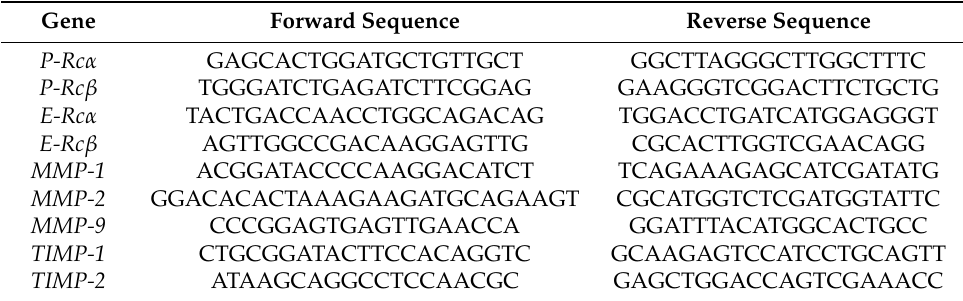
Table 4. Sequences of target